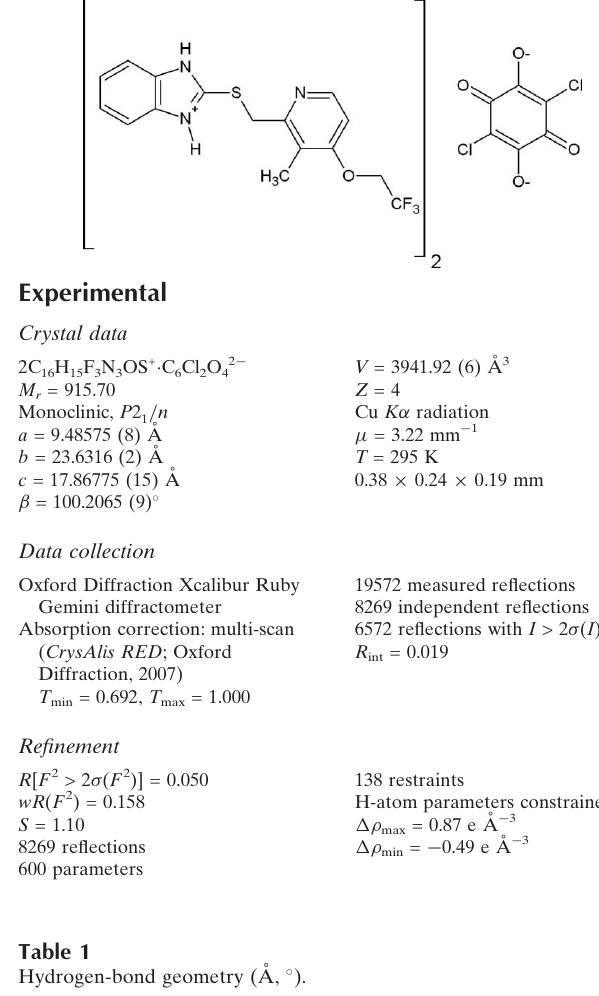
Hydrogen-bond geometry (A˚ , (cid:4) ). D —H (cid:2)(cid:2)(cid:2)